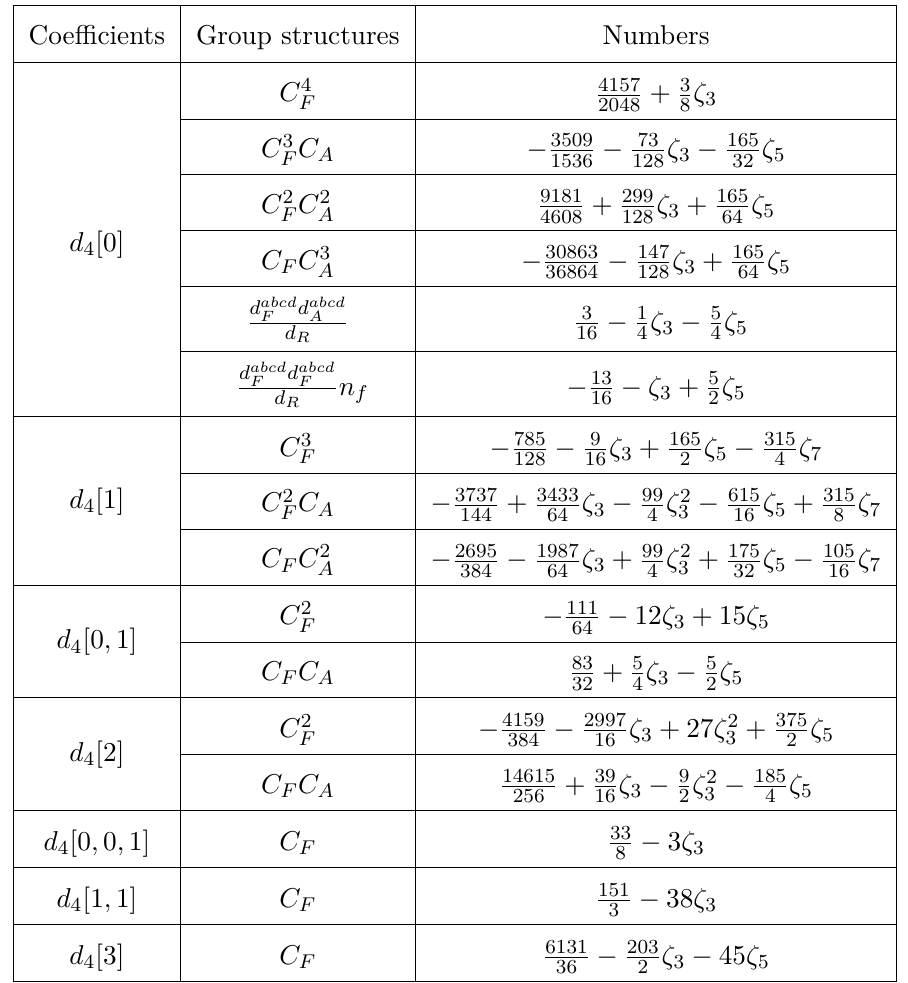
Table 2 . All terms included in the { β } -expansion of coefficient d 4